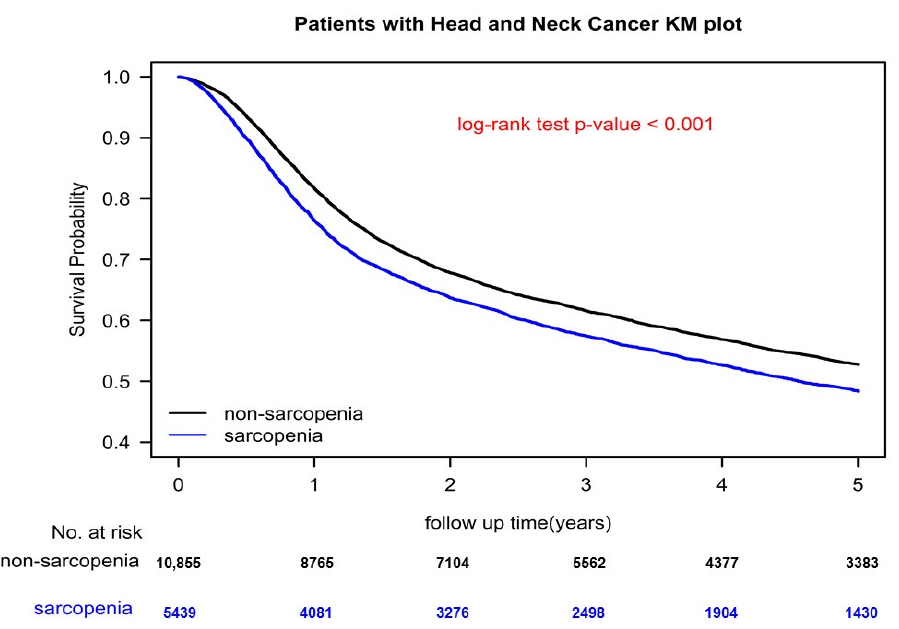
Figure 1. Kaplan–Meier overall survival curves for the propensity score-matched sarcopenia and nonsarcopenia groups (controls).